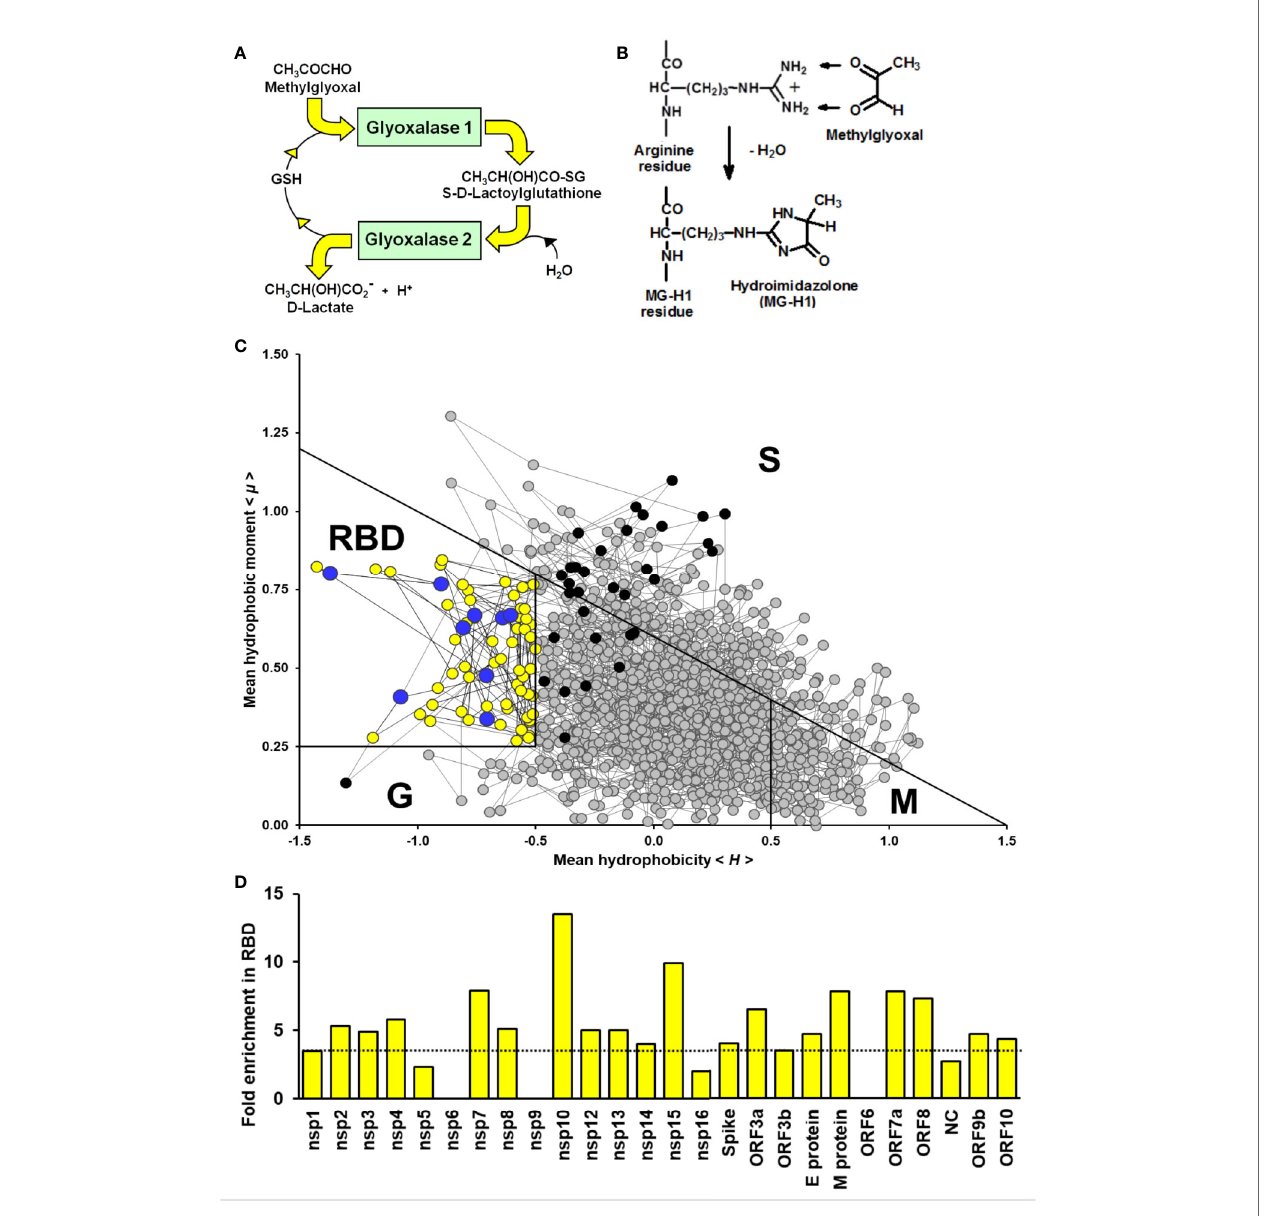
FIGURE 1 | Methylglyoxal — an endogenous arginine-modifying reactive metabolite and receptor binding domain analysis of functional arginines in the SARS-CoV-2 proteome. (A) Metabolism of methylglyoxal by the glyoxalase pathway (Rabbani et al., 2016b). (B) Modi fi cation of arginine residues by methylglyoxal (MG) to form hydroimidazolone, MG-H1. (C) Receptor binding domain (RBD) plot for SARS-CoV-2 Spike protein. Line-linked fi lled circles represent the primary sequence. The RBD is the area bound by the trapezium in the upper left-side region of the chart. Key: arginine residue in the RBD; , arginine residues outside the RBD; , other amino acid residues in the RBD; and , other amino acid residues outside the RBD. Other predicted domains: surface (S), globular (G), and membrane (M). (D) Arginine enrichment in individual proteins of SARS-CoV-2 proteins. Proteins not shown have no arginine residues (nsp11, ORF7b and ORF14). Dotted line - mean fold enrichment of the human host proteome,